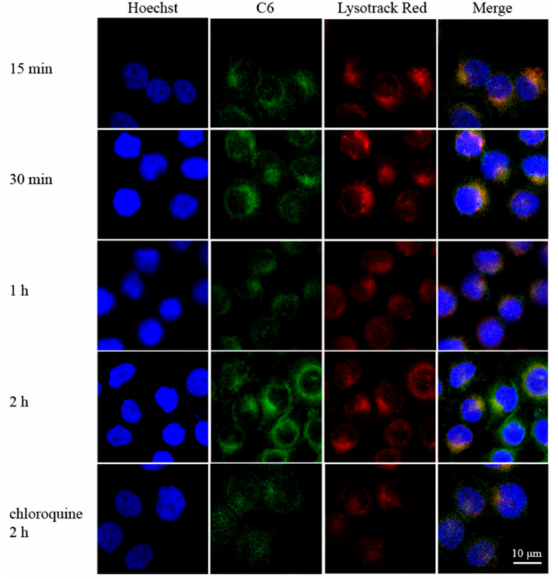
Figure 9. The CLSM images of the MS incubated with C6 / PPM for 15 min, 30 min, 1 h, 2 h, and with chloroquine for 2 h. Blue, green, and red colors indicate Hoechst 33258, C6, and LysoTracker Red, respectively. Scale bars, 0.01